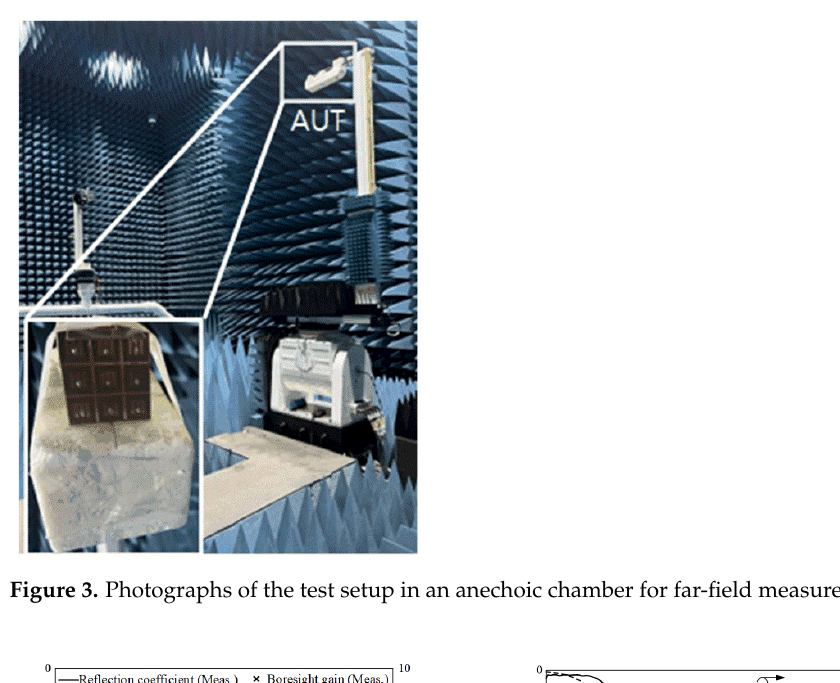
Figure 3. Photographs of the test setup in an anechoic chamber for far-field measurements.